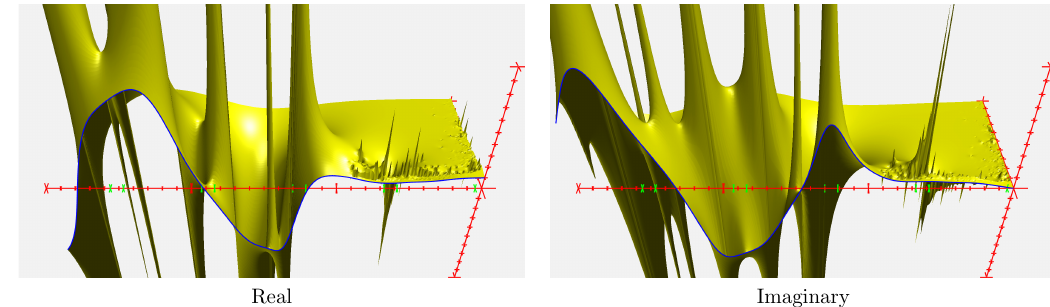
Fig. 6. The real and imaginary components of the response function at Portishead. Axes as in Fig. 5